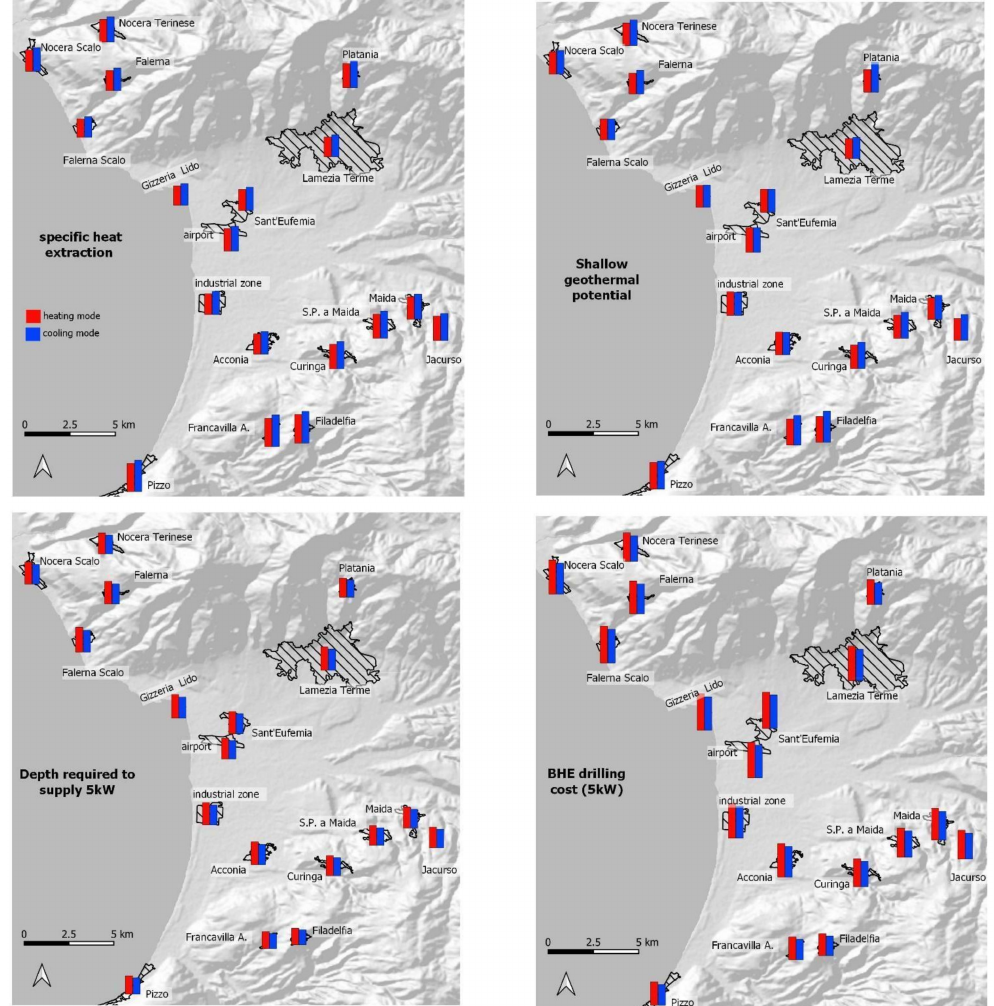
Figure 8. Histograms of the mean values of sHE, Q BHE , drilling depth and costs, for heating and cooling modes, calculated for the main municipalities and strategic sites (industrial areas and